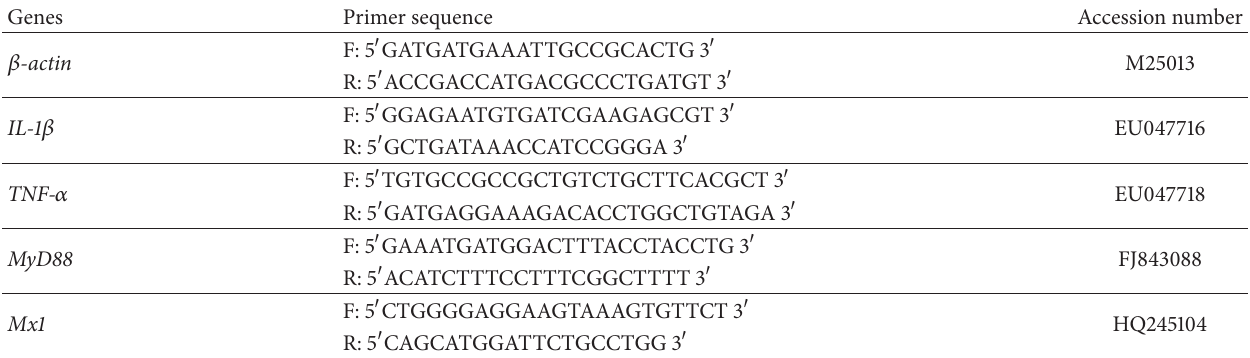
Table 1: Primers used for the analysis of mRNA expression by real-time